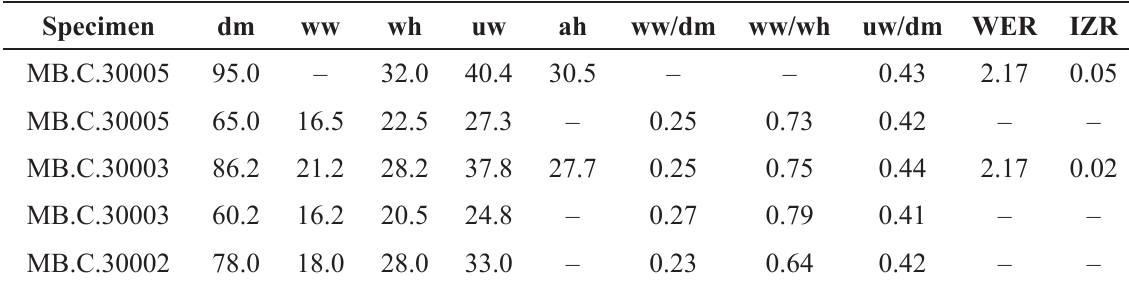
Table 27. Conch dimensions (partly estimated) and ratios of selected specimens of Lutites profundus Korn & Hairapetian gen. et sp. nov. from Baghuk